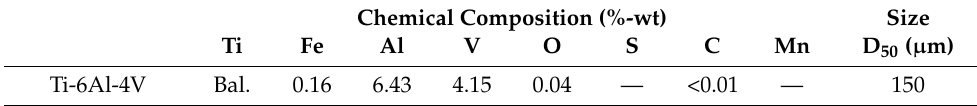
Table 1. Chemical composition and average size of the base powder